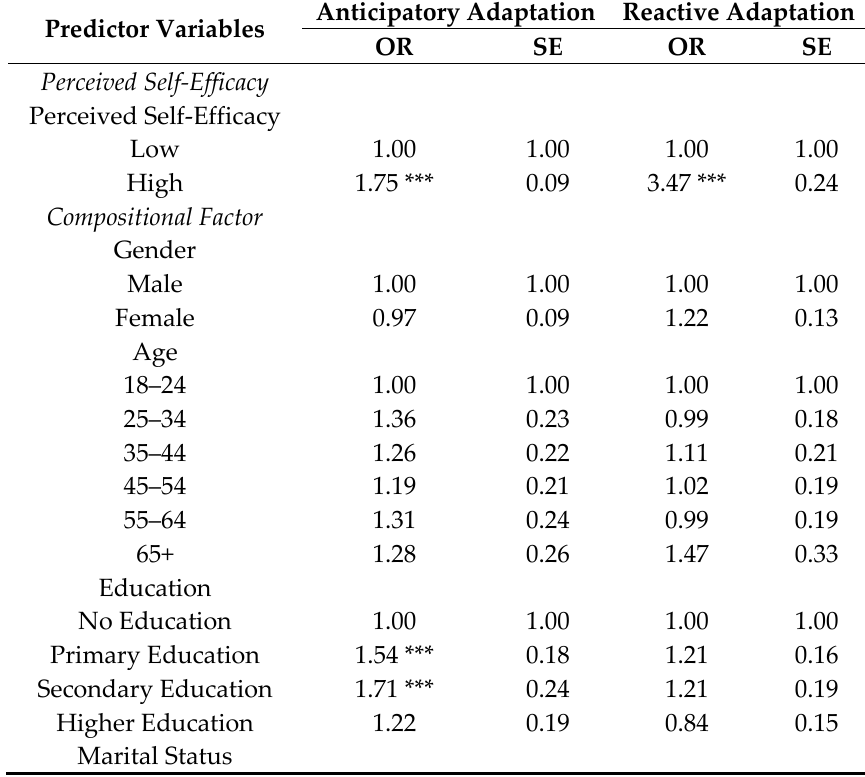
Table 3. Bivariate Ordered Logistic Regression Analysis on Anticipatory and Reactive Adaptation to Climate Change in Coastal Cambodia ( n =